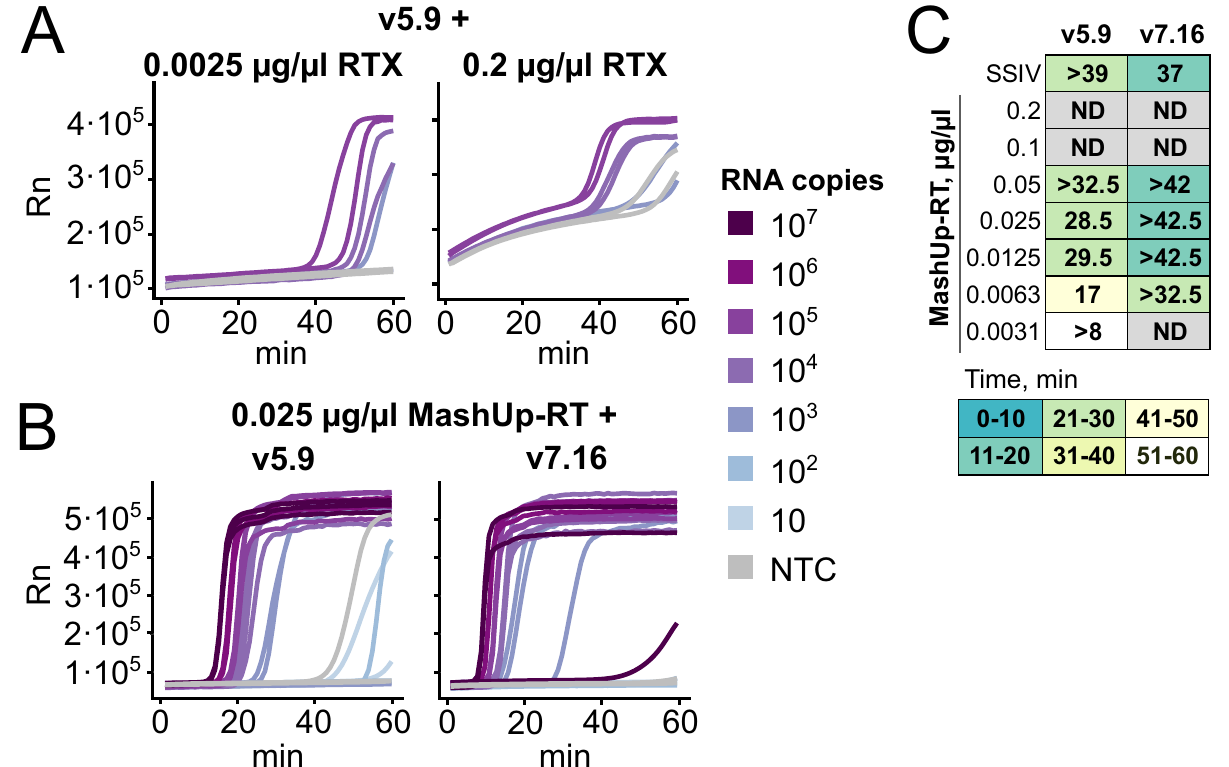
Figure 2. Compatibility of v5.9 and v7.16 polymerases with non-commercial thermostable RT enzymes. All experiments shown were set up with iLACO primers and run for 1 h at 65 °C in a thermocycler, tracked by Eva Green fluorescence. ( A ) Example amplification plots showing the performance of v5.9 with low or high amounts of RTX (duplicates of 83,000, 8300, and 830 copies of synthetic RNA as well as non template control (NTC)). ( B ) Optimal detection of synthetic SARS-CoV-2 RNA using v5.9 (0.03 µg/µl in ThermoPol buffer) or v7.16 (0.025 µg/µl in IA buffer) supplemented with MashUp-RT as the thermostable reverse transcriptase. Reactions were performed in triplicate. ( C ) Optimization of MashUp-RT enzyme amount in combination with v5.9 and v7.16 in their respective optimal conditions (see above for B). 10,000 copies of synthetic RNA and NTC were assayed. Time between positive and negative amplification is indicated in minutes and the color indicates time for detection of the positive controls, as in Fig.